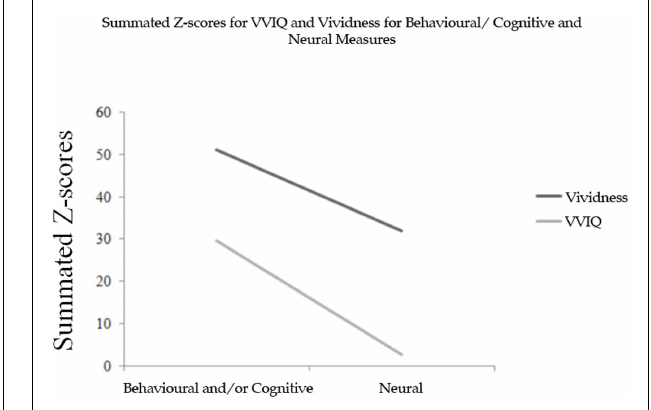
FIGUREA2 | Summed Z -scores for vividness andVVIQ for neural and behavioral and/or cognitive